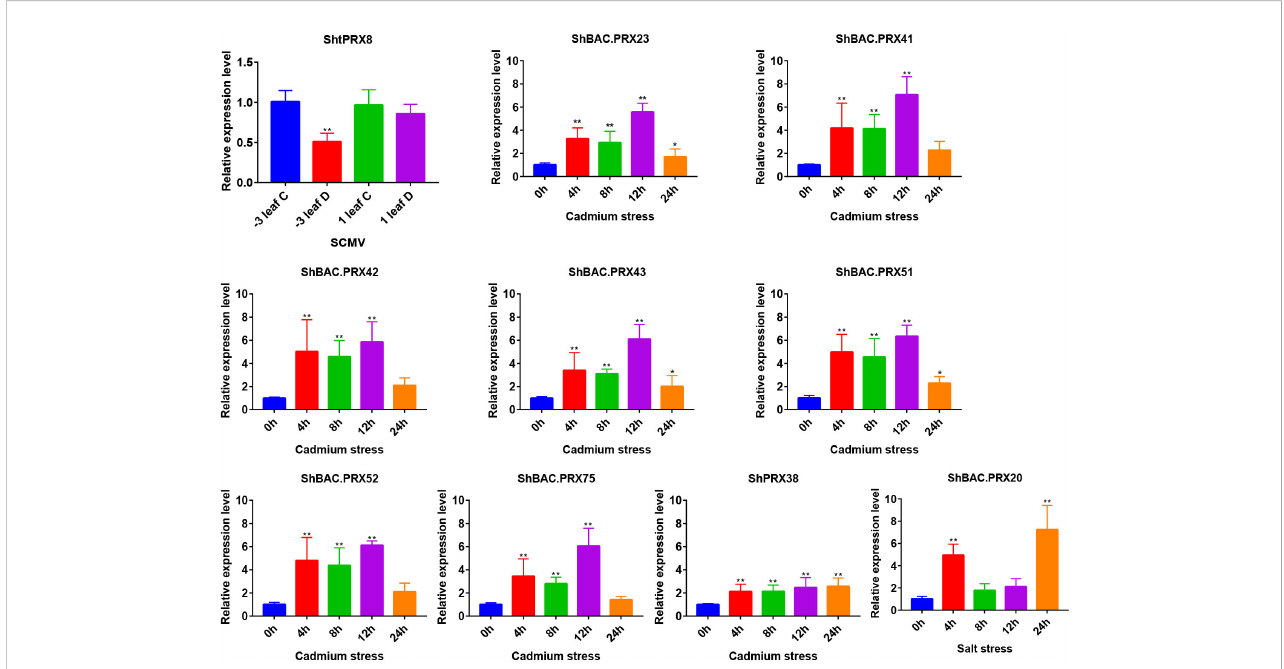
FIGURE 7 Analysis of SCMV, Cd, and salt stress differentially expressed PRX gene family members in sugarcane. The black bar graphs represent the relative expression levels of PRX family genes in the leaves under SCMV, Cd, and salt stresses. The − 3 leaf C, the − 3 leaf of virus-free Badila; the 1 leaf C, the +1 leaf of virus-free Badila; − 3 leaf D, the -3 leaf of post-SCMV infection Badila (symptomatic leaf); 1 leaf D, the +1 leaf of post-SCMV infection Badila (asymptomatic leaf); *: 0.01 < p < 0.05, **: p < 0.01; The mean and SD were calculated from three biological and three technical replicate